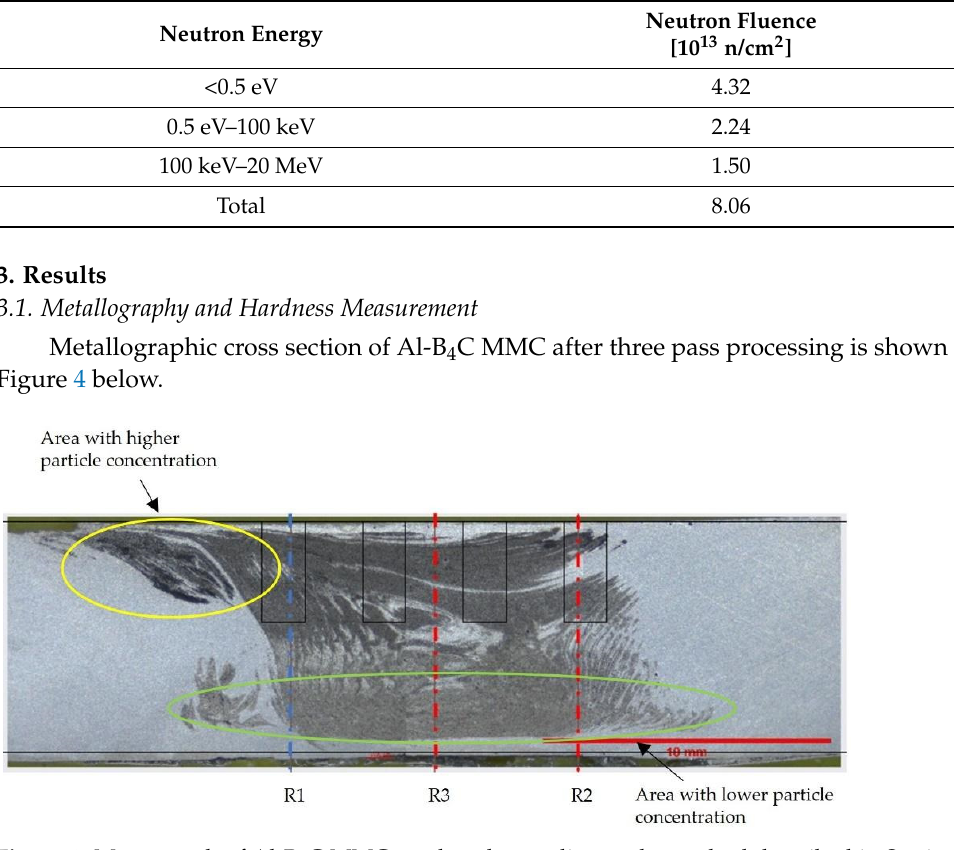
Figure 4. Macrograph of Al-B 4 C MMC produced according to the method described in Section 2 (Three-pass FSAP). Color of tool axes and description of tools are taken from Figure 2. Groove geometry is depicted black, area with higher particle concentration circled yellow. Area with lower particle concentration is circled green.